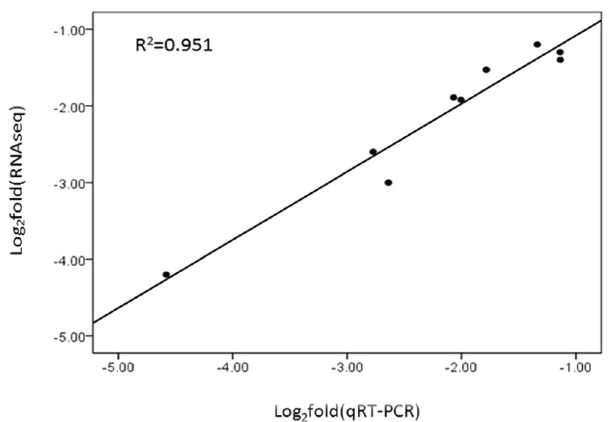
Figure 9. Linear regression analysis of fold change data between qRT-PCR and RNA-seq. Black dots represent log 2 transformed fold change values of a single gene in APFL sample obtained from qRT-PCR (X-axis) and RNA-seq analysis (Y-axis). R: correlation